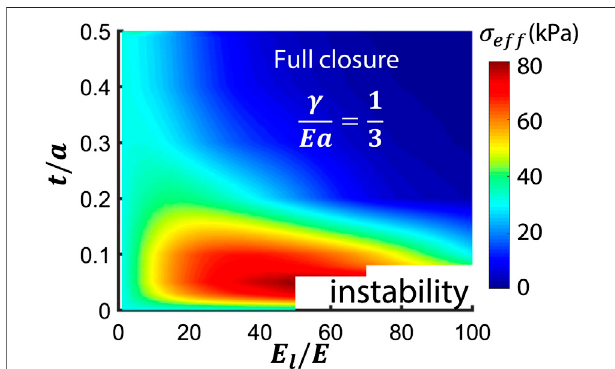
FIGURE 8 | A contour plot of effective adhesive strength σ eff as a function of normalized thickness and Young ’ modulus of the reinforcing layer. Results are obtained under full closure with an elasto-capillary number c / ( Ea ) (cid:3) 1 / 3. [reprinted with permission from (Wang et al., 2017b)].